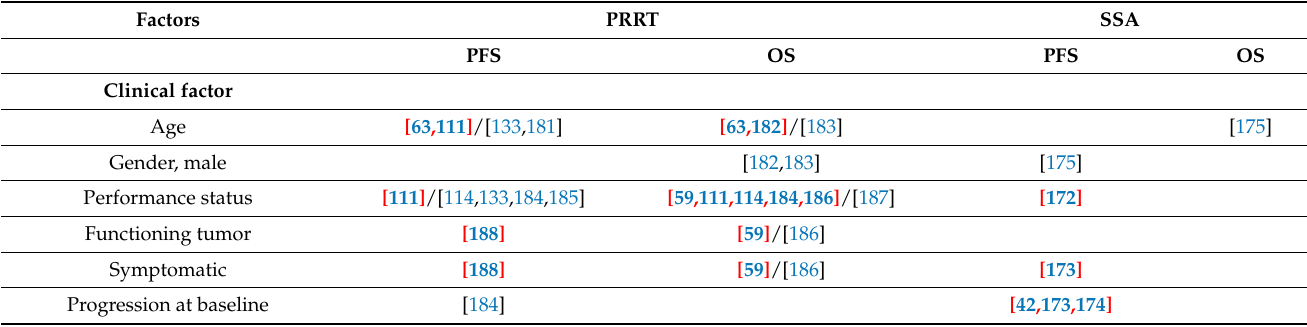
Table 2. Factors associated with worse PFS and OS with SSTR-targeting therapy (ss and PRRT) in advanced